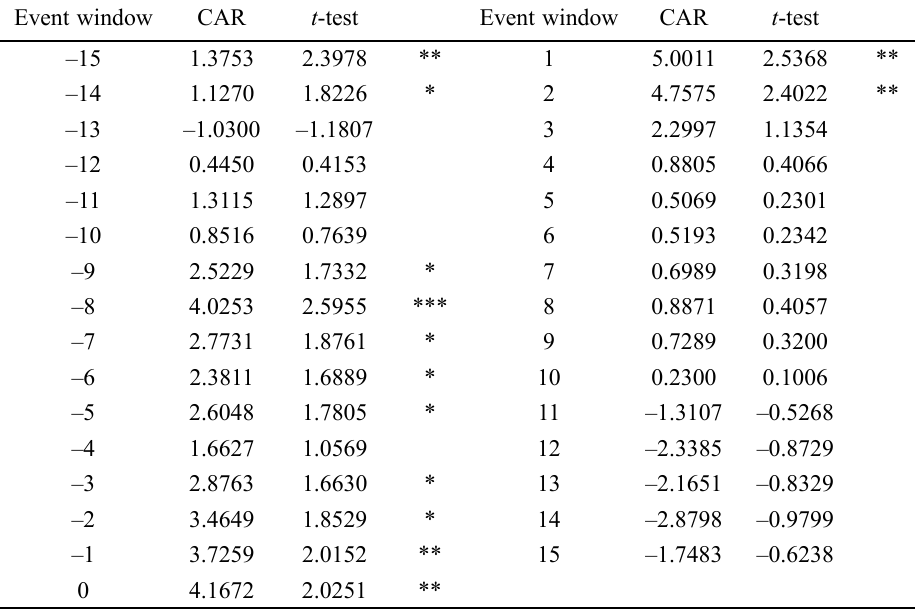
Table 6. CAR of medical product during the period of infectious diseases Event window